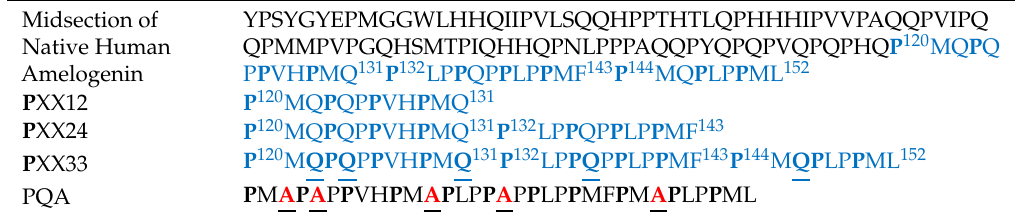
Table 1. Series of polyproline repeating motifs derived from the tail end of the mid-section (P 120 to L 152 represented in blue) of native human amelogenin and substitution of glutamine for alanine in PX33 to give PQA peptide. The latter most peptide resulted in unsuitable crystals for remineralisation. YPSYGYEPMGGWLHHQIIPVLSQQHPPTHTLQPHHHIPVVPAQQPVIPQ Midsection of Native Human QPMMPVPGQHSMTPIQHHQPNLPPPAQQPYQPQPVQPQPHQ P 120 MQ P Amelogenin